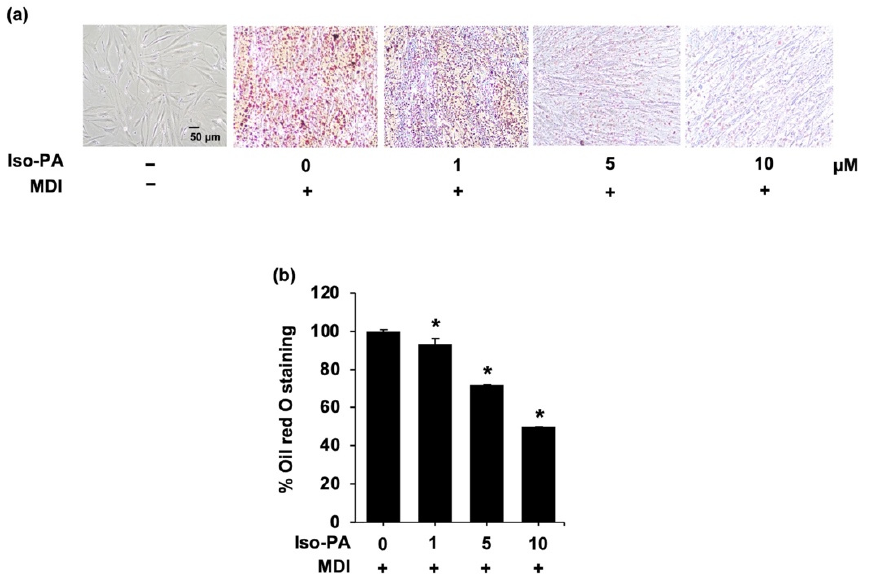
Figure 8. The suppressive effect of isopanduratin A on lipid accumulation in differentiated human PCS-210-010 preadipocytes cultured with isopanduratin A was assessed by Oil Red O staining and represented as percentage of Oil Red O staining. ( a ) Confluent 3T3-L1 cells were cultured in the presence (+) or absence ( − ) of differentiation medium (MDI) with 0–10 μ M isopanduratin A (Iso-PA). Cells treated with 0.5% v / v DMSO functioned as untreated control (0). ( b ) Bar graphs demonstrating mean ± SD (n = 3) were created using GraphPad Prism. A one-way ANOVA with Tukey’s post hoc test was used to compare the means of treatment and differentiated control groups (* p < 0.05) .